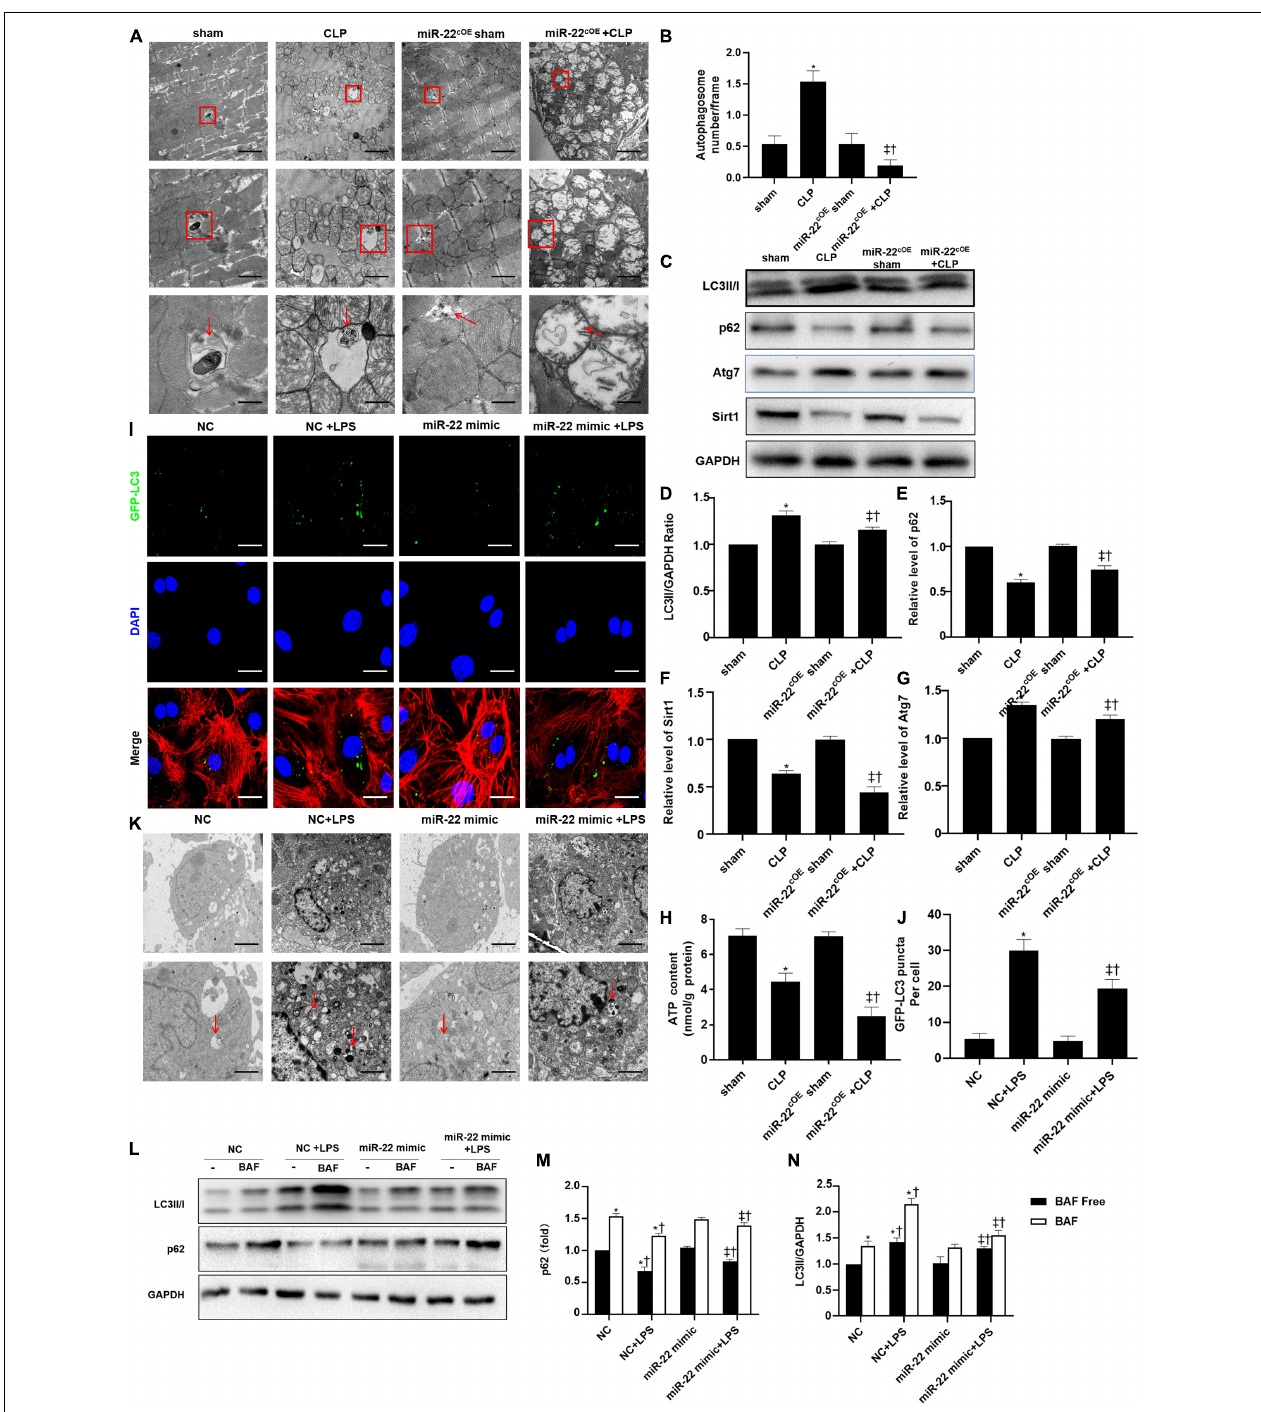
FIGURE 6 | Overexpressing miR-22 reduces autophagy levels in CLP-induced cardiomyopathic myocardium and inhibits autophagic flux in vitro in the presence of LPS. (A) Representative images of myocardial mitochondria ultrastructural morphology that underwent different treatments. (B) Quantity of autophagosomes. (C) Representative images of blots. (D) LC3-II/GAPDH ratio. (E) Relative p62 protein level ratio. (F) Relative sirt1 protein level ratio. (G) Relative Atg7 protein level ratio; Data were expressed as mean ± SEM. ∗ P < 0.05 vs. sham group; ‡ P < 0.05 vs. CLP group; † P < 0.05 vs. miR-22 cOE sham group. (H) ATP content ( n = 6). (I,J) Representative images and quantitative analysis of GFP-LC3 puncta; Scale bar = 20 µ m. (K) Representative images of mitochondria in neonatal mice cardiomyocytes. (L–N) Relative p62 protein level ratio with or without bafilomycin A1 treatment in condition of LPS; LC3-II/GAPDH ratio with or without bafilomycin A1 treatment in condition of LPS. ∗ P < 0.05 vs. NC group; ‡ P < 0.05 vs. NC + LPS group; † P < 0.05 vs. miR-22 mimic group. All the experiments were repeated three times.